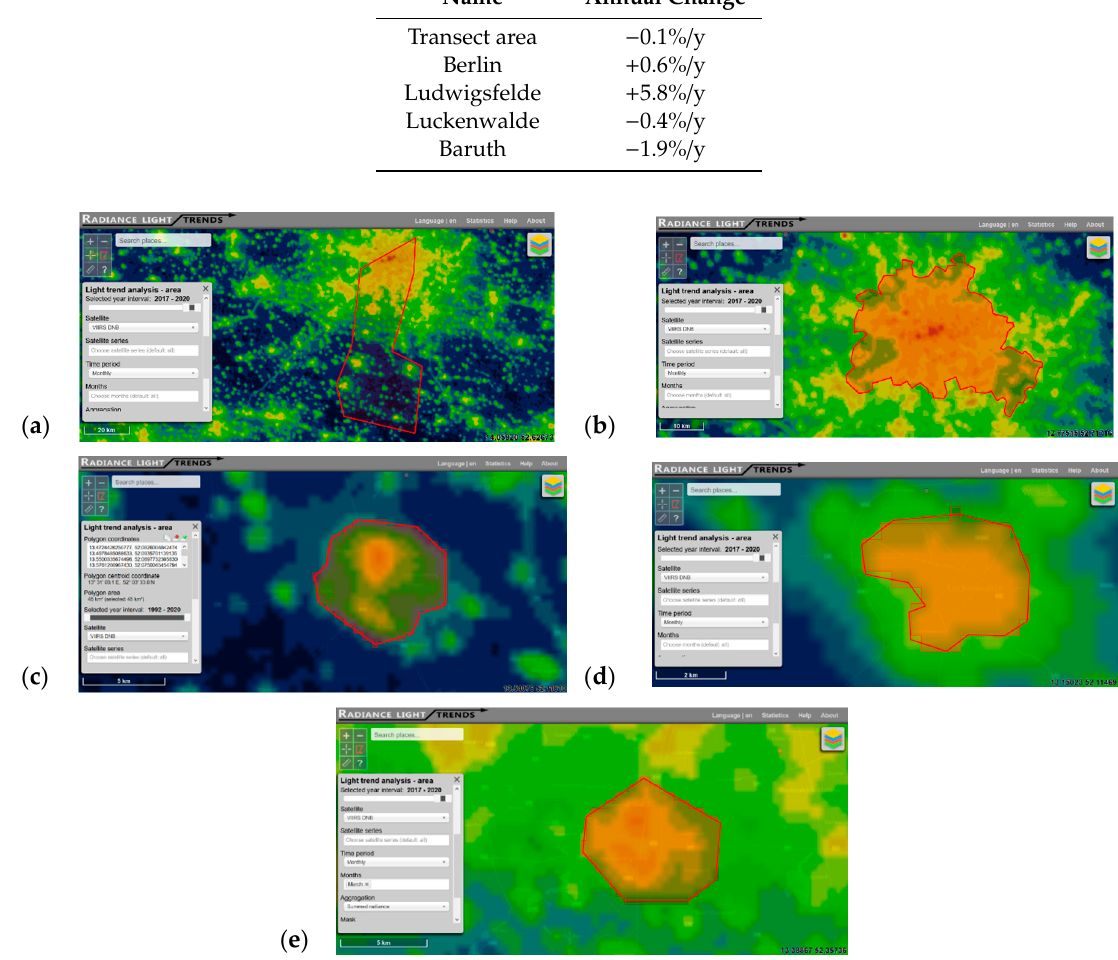
Figure A8. VIIRS DNB time series obtained from radiance light trend web tool [39]: ( a ) the study area; ( b ) Berlin; ( c ) the town of Baruth; ( d ) the town of Luckenwalde; and ( e ) the town of Ludwigsfelde.